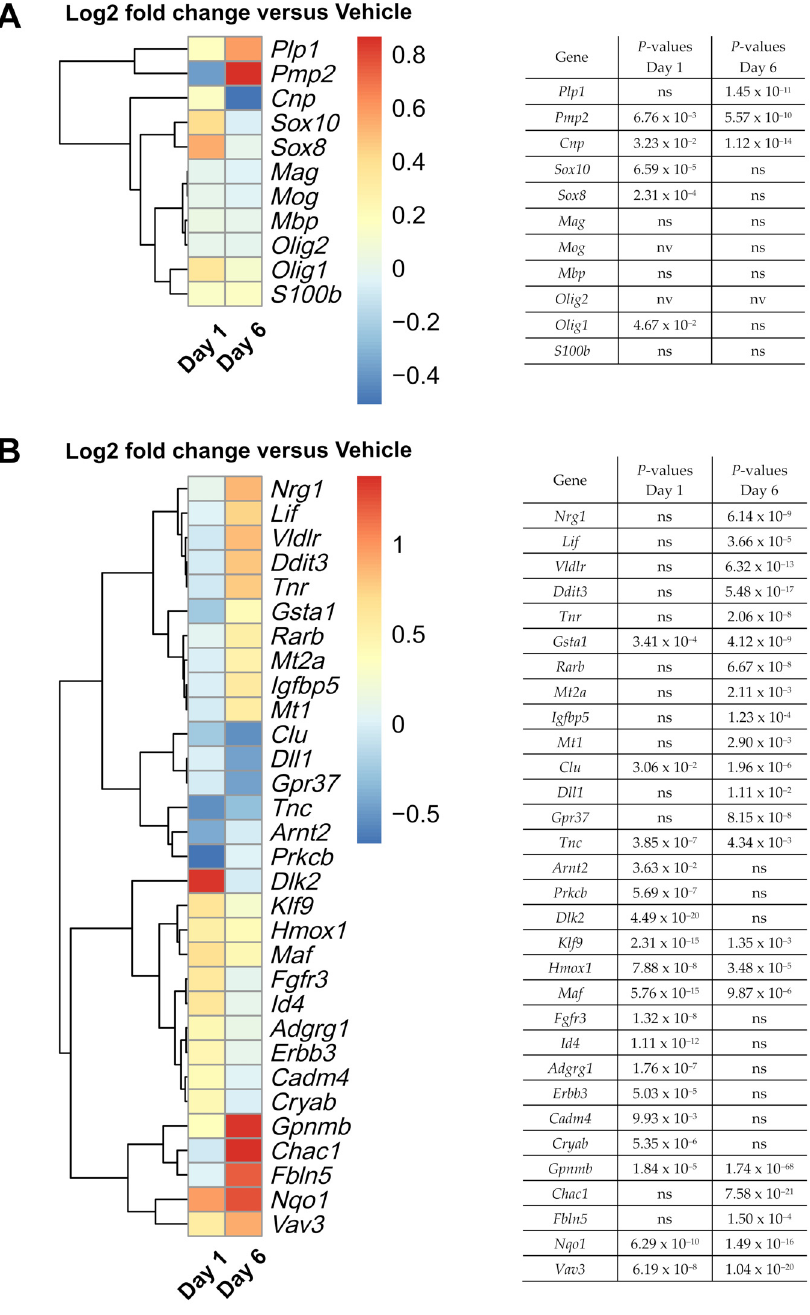
Figure 4. Effects of nimodipine on gene expression in OLN-93 cells, as assessed by whole-genome RNA sequencing. ( A ) Heatmap shows the effects of 10 µ M nimodipine on the RNA expression of a range of common myelin-related genes on Days 1 and 6 compared with dimethyl sulfoxide (vehicle) treatment in OLN-93 cells incubated in oligodendrocyte differentiation medium. ( B ) Heatmap